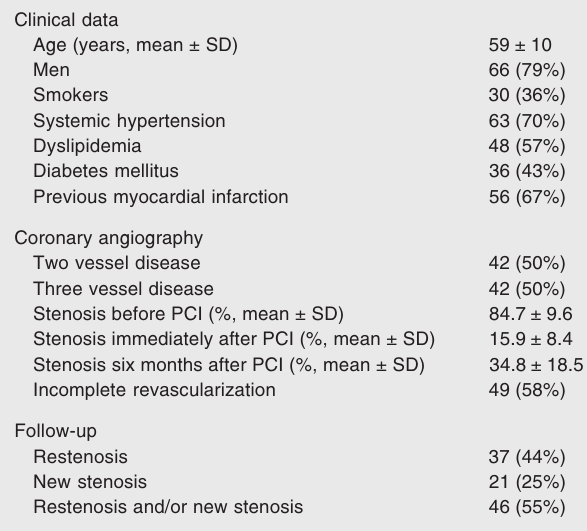
Table 1. Clinical and angiographic data of the patients